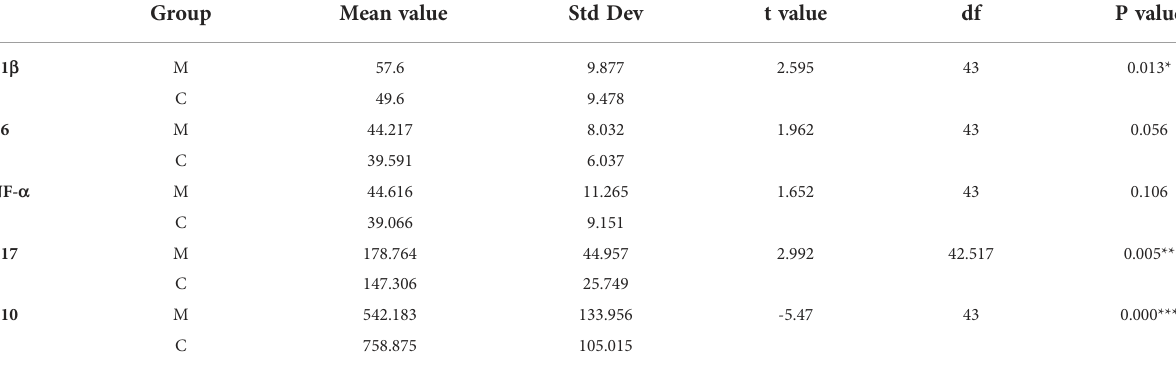
TABLE 3 Comparison of salivary in fl ammatory factors in the methamphetamine using (M) and control (C) groups. Group